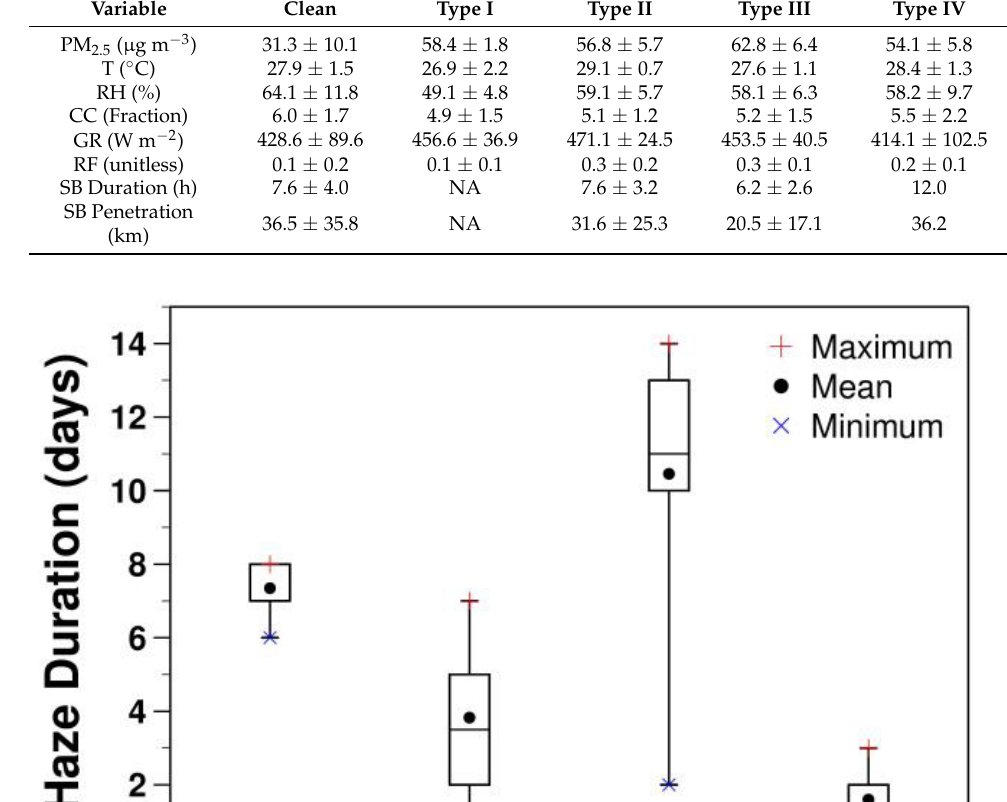
Table 3. PM 2.5 and different meteorological variables (mean ± standard deviation) by haze type.